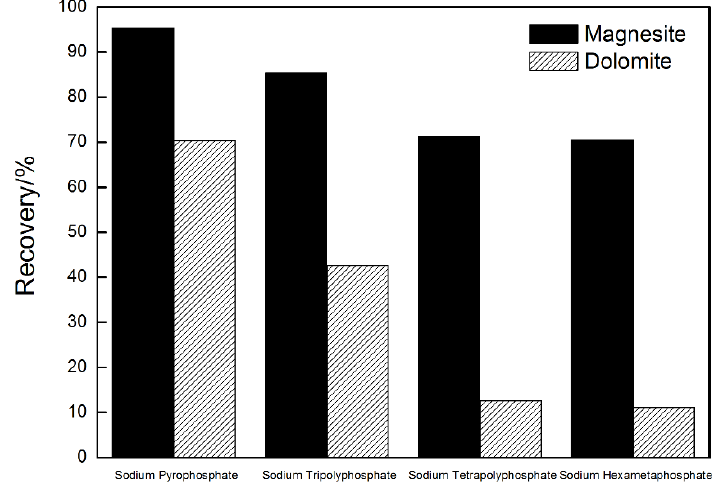
Figure 8. The influence of phosphate chain length on flotation selectivity.